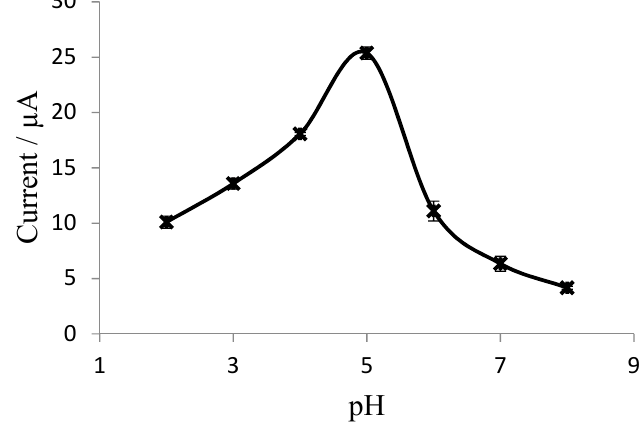
Figure 2. The effect of pH on the anodic peak potentials in 0.5 μ M Tartrazine solution on microspheres-laccase/AuNPs/SPE. Exposure time: 2 min. Error bar represents the standard deviation of triple measurements.